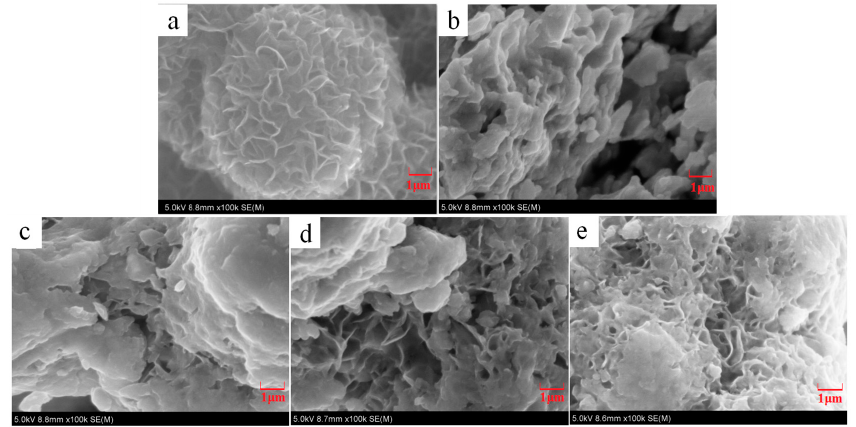
Figure 2. SEM images of MoS 2 , Ni 2 P, and three MoS 2 /Ni 2 P hybrids: ( a ) MoS 2 ; ( b ) Ni 2 P; ( c ) MoS 2 /Ni 2 P- 38; ( d ) MoS 2 /Ni 2 P-50; and ( e ) MoS 2 /Ni 2 P-58.